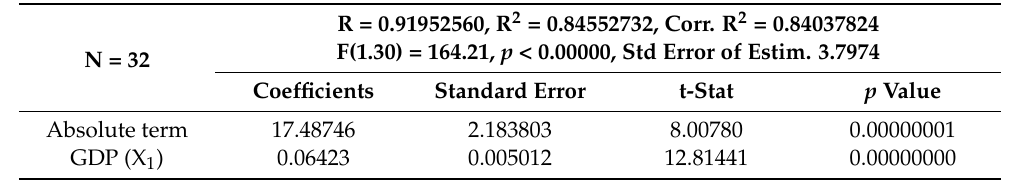
Table 4. Results of modeling the share of renewable energy sources in gross marginal energy consumption in Sweden in 1991–2022 using a linear econometric model of one